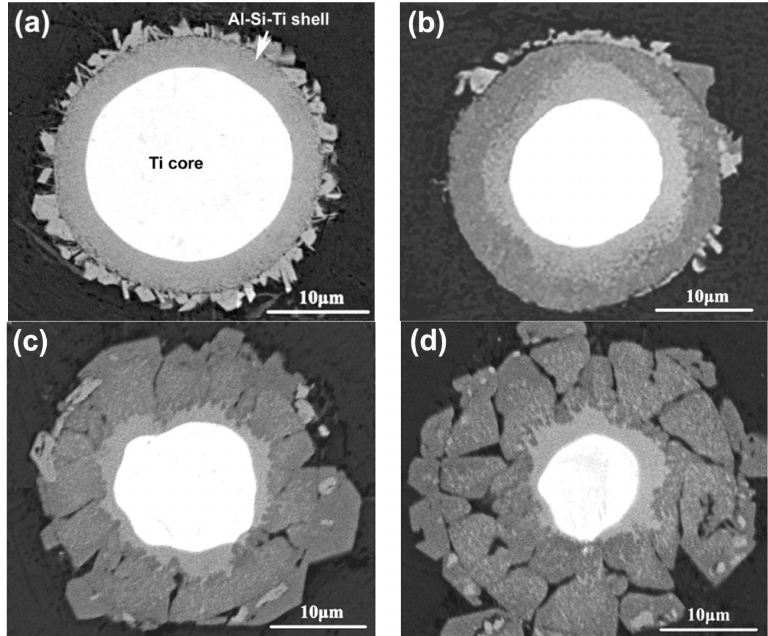
Figure 3. SEM images of reinforcing particles in the composites thixoformed at reheating temperatures of ( a ) 590 ◦ C, ( b ) 600 ◦ C, ( c ) 605 ◦ C, and ( d ) 610 ◦ C.